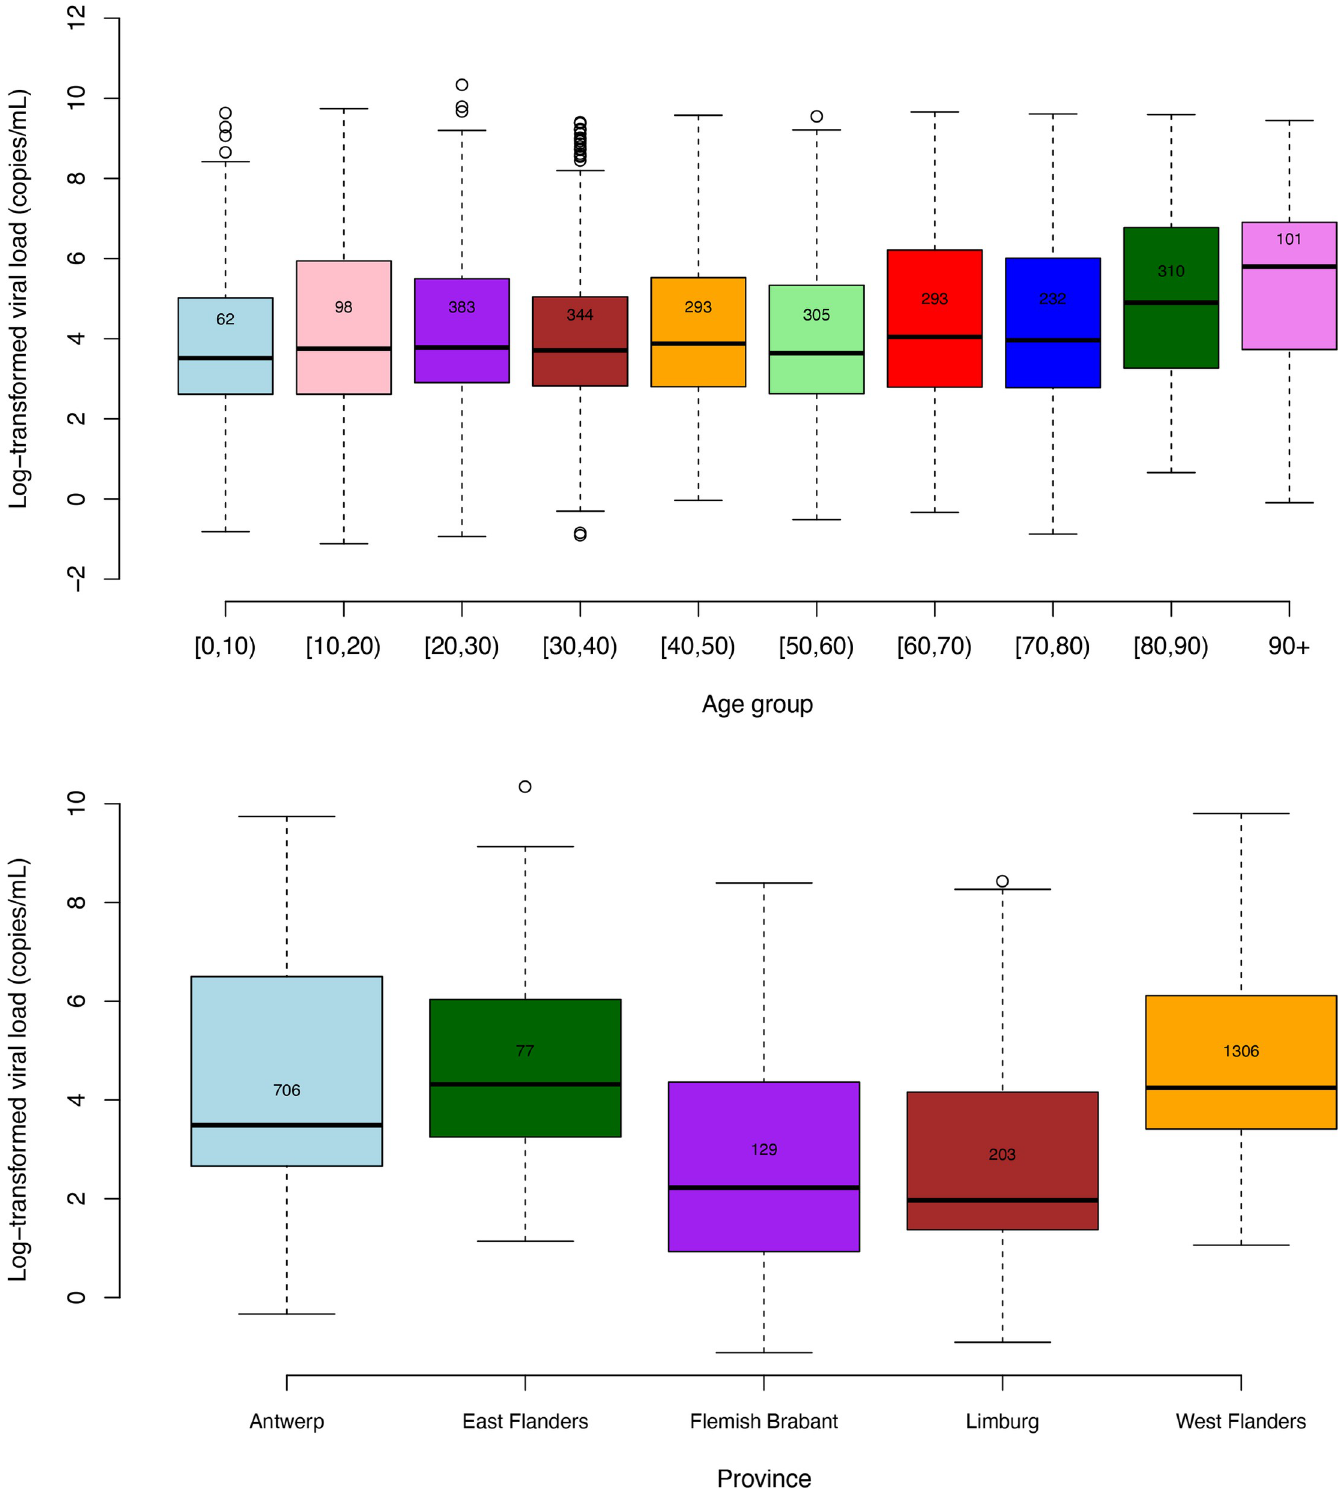
Fig 4. Boxplots of the log-transformed viral load (in copies/mL) for SARS-CoV-2 positive a-/pre-symptomatic patients by age (upper panel) and province (lower panel) with reported number of observations per group within the boxplots and data collected between 1 April 2020 to 31 March 2021.